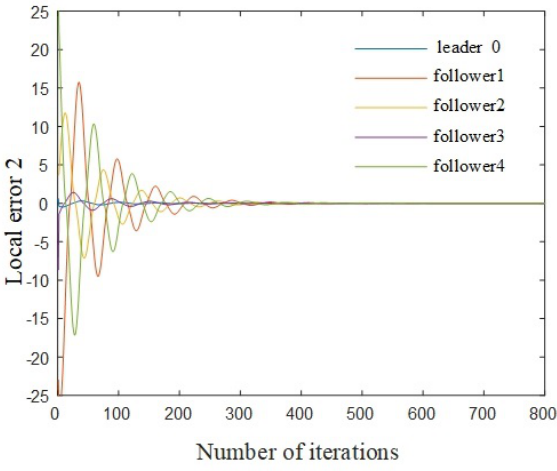
Fig. 3. The finite time local error ε i 1 ( k ) in (11).